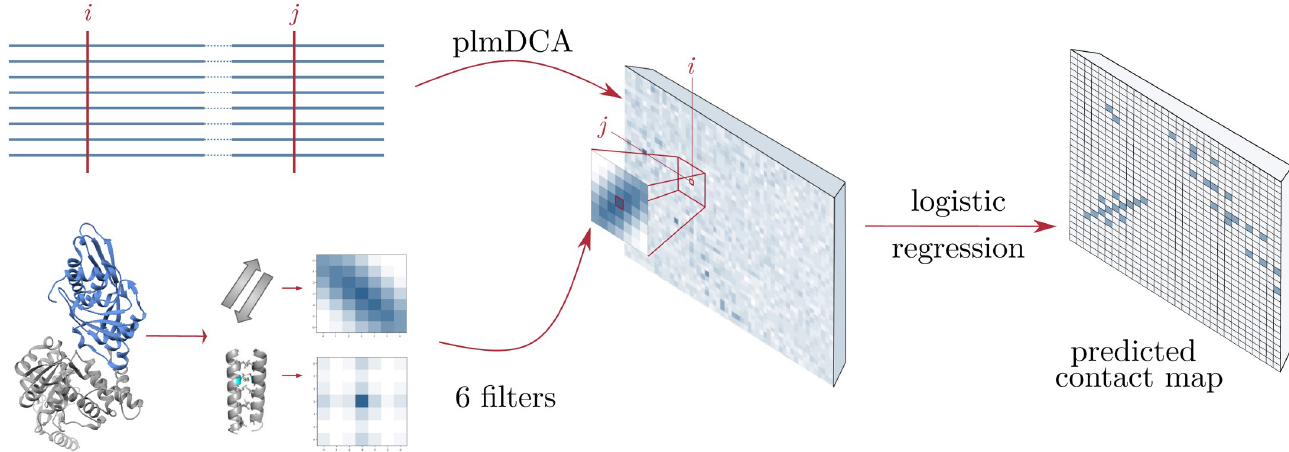
Fig 3. General scheme of FilterDCA: Our approach combines the results of plmDCA applied to two-domain MSAs with structural filters constructed as average contact matrices using 6 contact classes. Structural supervision is used to learn a logistic regression based on the plmDCA score itself, and the best correlation with one of the six structural